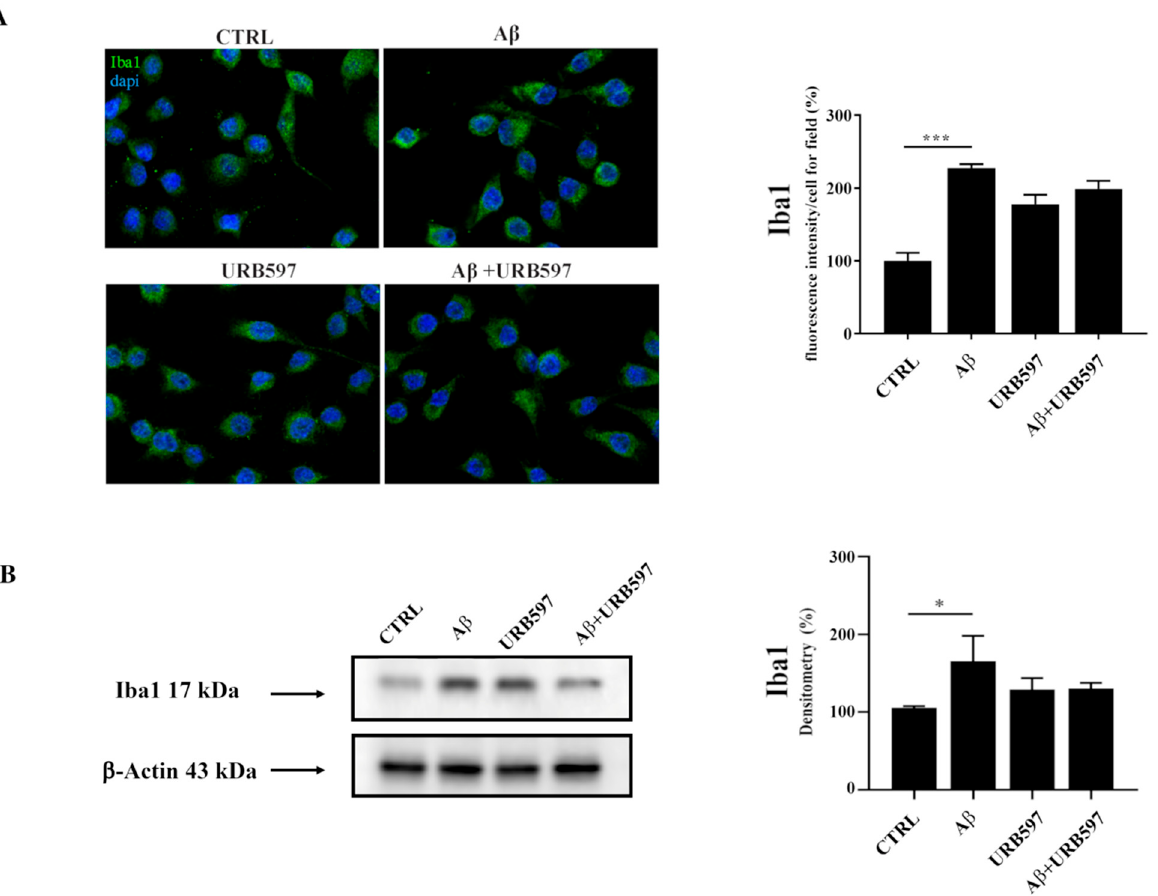
Figure 1. ( A ) Immunofluorescence analysis of Iba1 in BV-2 cells treated with 30 µM A β 25–35 for 24 h. Quantization of the intensity of the fluorescence signal was performed using the ImageJ software. The results are expressed as the mean ± SD of three independent experiments. *** p < 0.001. Bar 20 µm; ( B ) Determination of Iba1 protein levels by western blot. The data were normalized to the β -actin signal, reported as percentage versus control (CTRL). Data are expressed as the mean ± SEM of three independent experiments. * p <